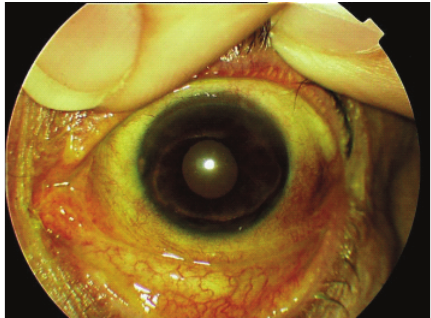
Figure 1: Ulcer with a necrotic base, raised border, and halo erythema on the left leg.